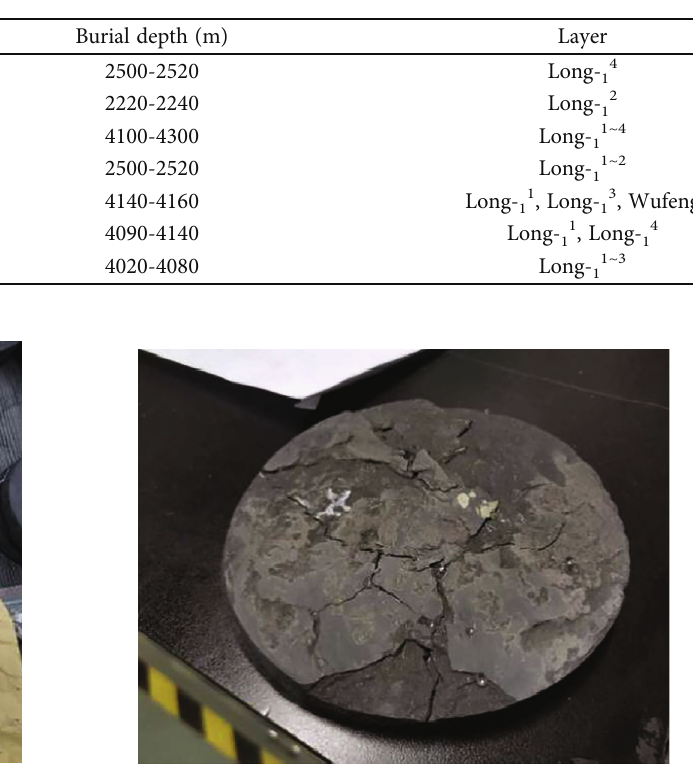
Figure 2: Core after grinding and testing (the red circle is the indentation area). Table 1: Data of cores for the Brinell hardness measurement.